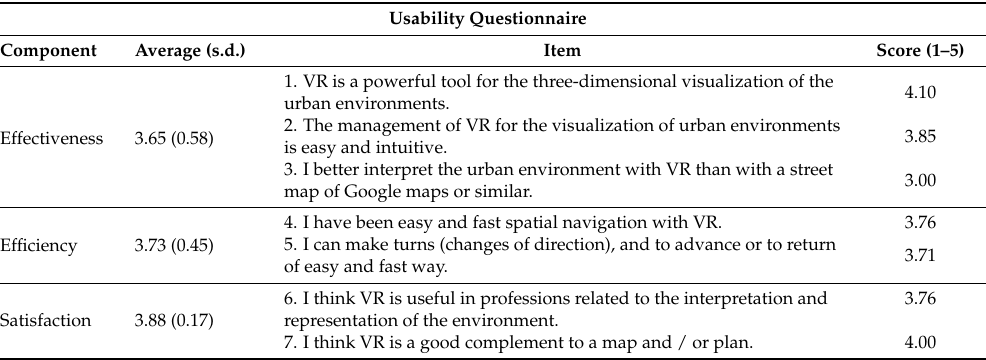
Table 2. Usability Questionnaire. (s.d. Standard